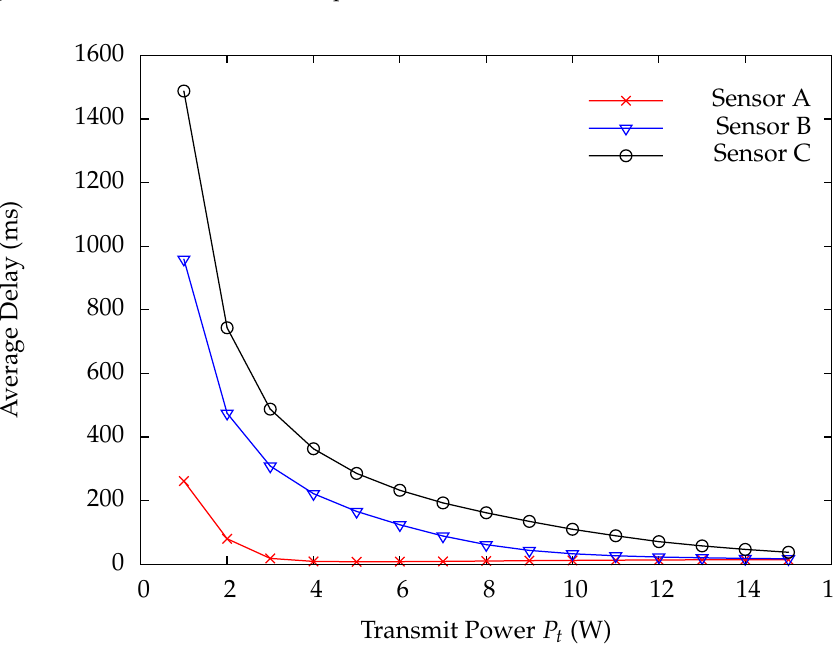
Figure 14. Average delay versus transmit power P t